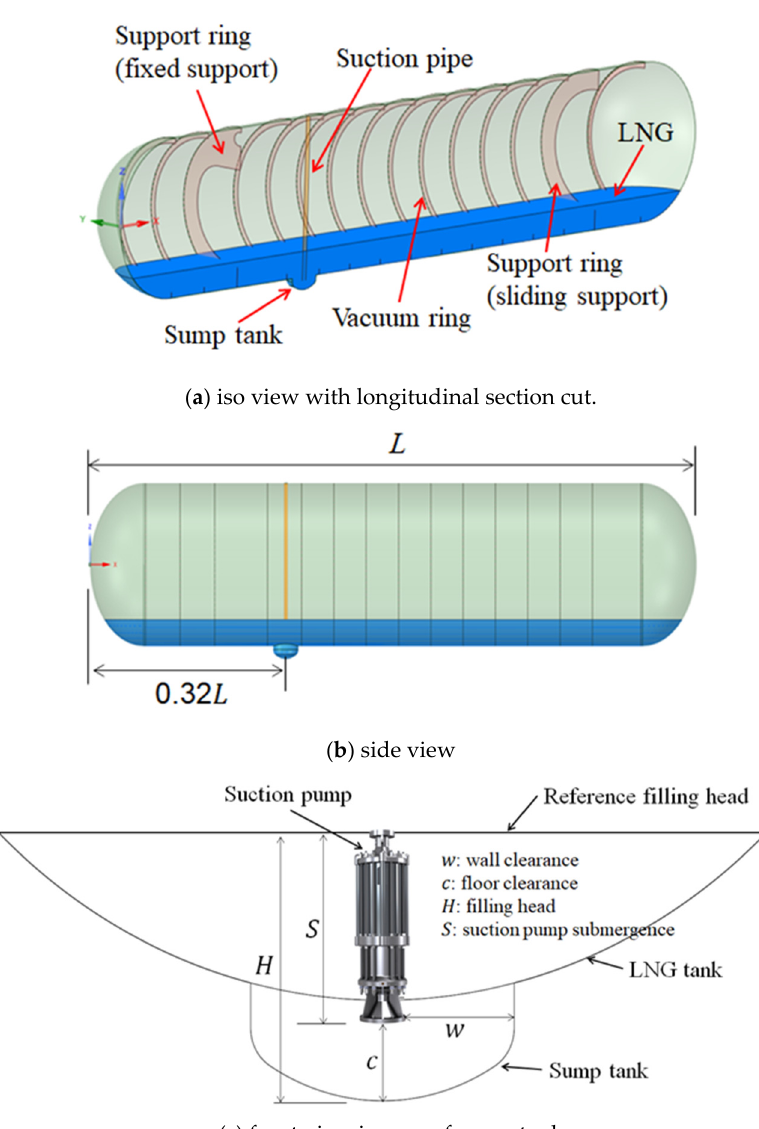
J. Mar. Sci. Eng. 2021 , 9 , x FOR PEER REVIEW Figure 3. Schematics of the LNG fuel tank. Figure 3. Schematics of the LNG fuel tank.